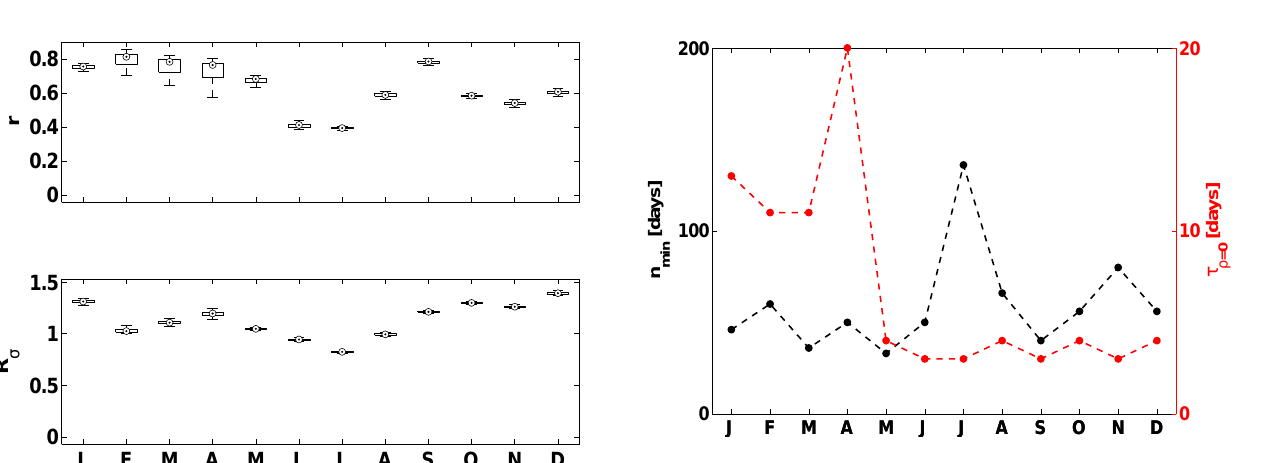
Figure 5. The black circles show the minimum number of AWS1 air temperature observations required for each calendar month’s model to obtain statistically significant skill ( n min , based on rea-ens-air, as described in the text). The red circles (right axes) show the decor- relation time ( τ ρ ∼ = 0 ), for each month’s daily air temperature time series recorded at